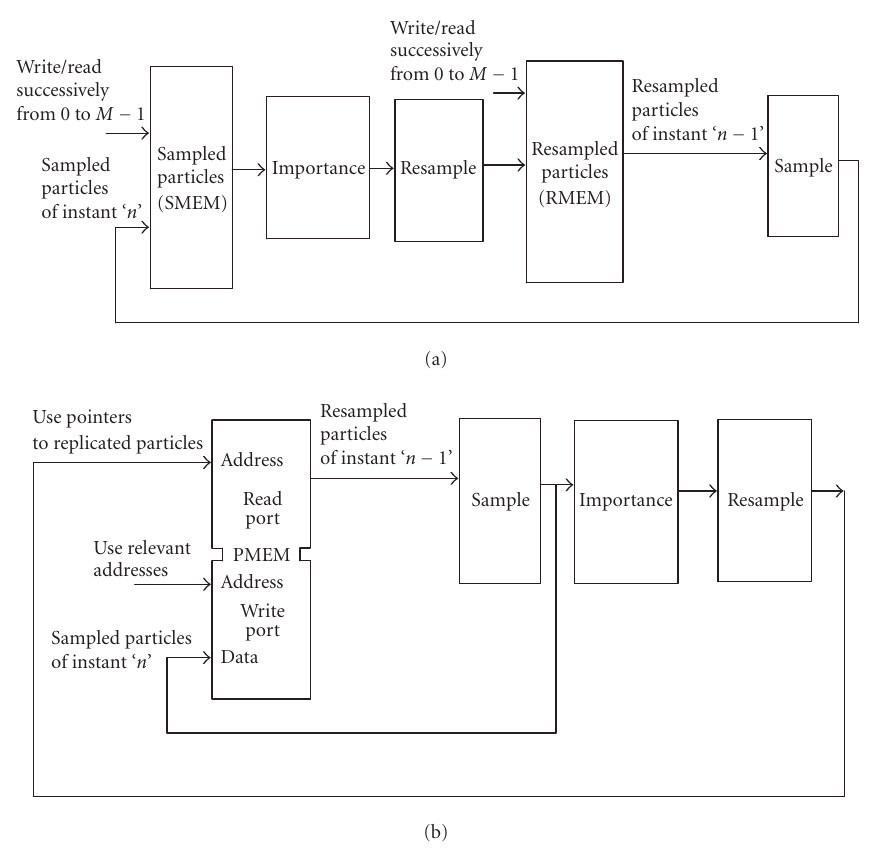
Figure 4: Memories for storing particles. In the traditional implementation two memories would be needed. These are replaced by a single dual-port memory. (a) Resampling requiring two memories. (b) Modified architecture needing only one dual-port memory.